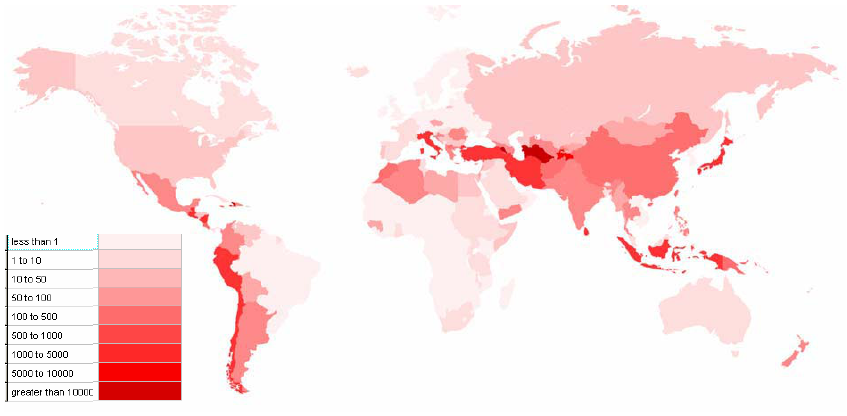
Fig. 11. Number of deaths for each country as a proportion of millions of population at the time of disaster integrated from 1900 to 2010. CATDAT v4.12, Daniell,